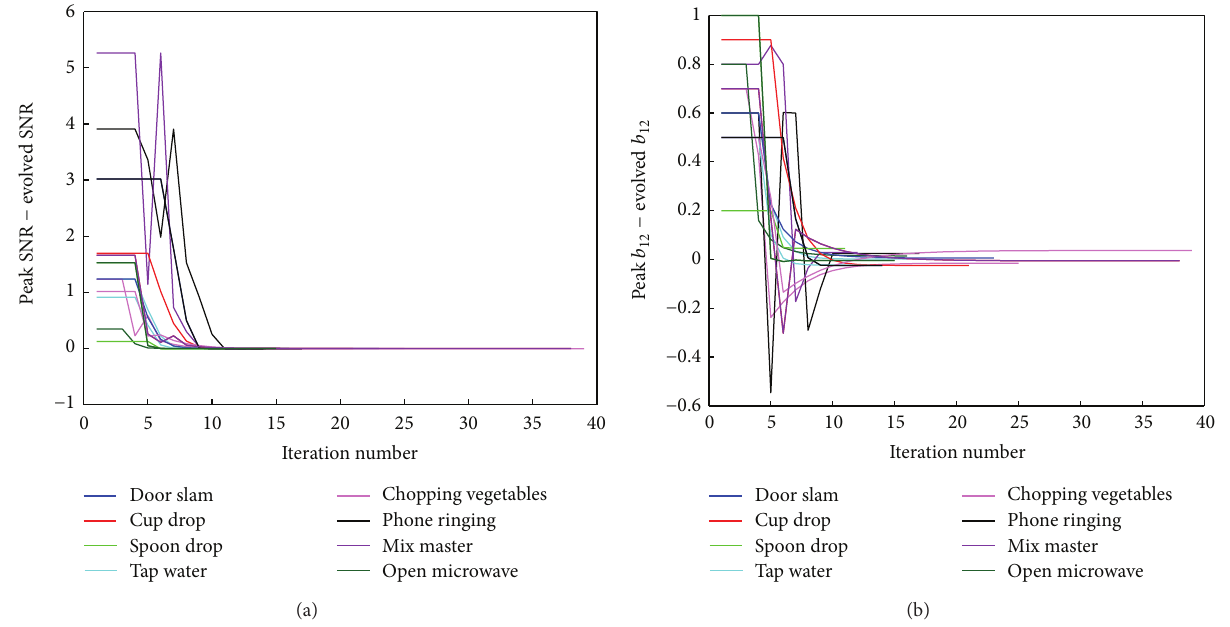
Figure 6: Convergence behaviour of the SSA algorithm: differences between the optimum SNR and evolved SNR (a) and optimum 𝑏 12 value minus evolved 𝑏 12 (b), for various example sounds of daily life (as indicated) with background radio noise at pleasant listening level, using microphones 1 and 3. Two SDLs from each sound class were chosen at